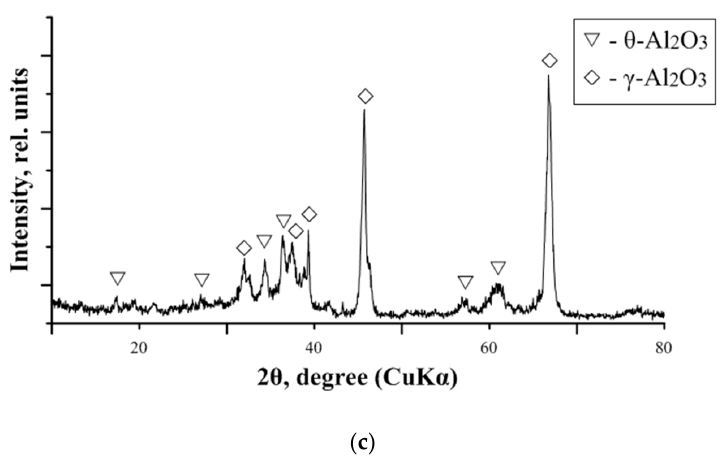
Figure 1. TEM image of the structure ( a ), particle distribution histogram ( b ), and powder X-ray diffraction [22] ( c ) of the Al 2 O 3 nanoparticles.